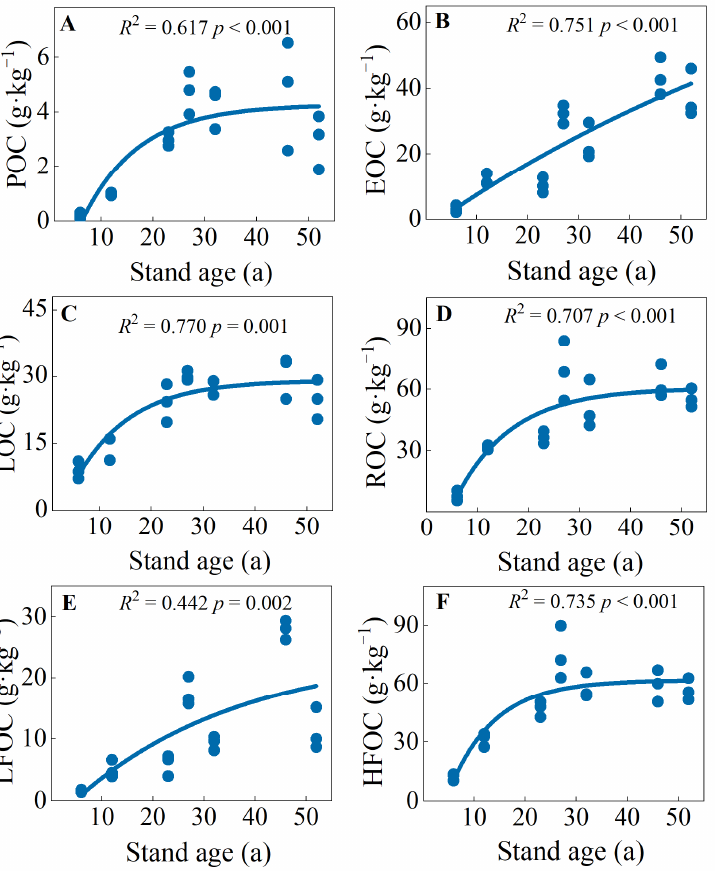
Figure 2. ( A ) soil particulate organic carbon (POC), ( B ) easily oxidizable carbon (EOC), ( C ) labile organic carbon (LOC), ( D ) recalcitrant organic carbon (ROC), ( E ) light fraction organic carbon (LFOC) and ( F ) heavy fraction organic carbon (HFOC) in C. japonica plantations of different stand ages in the rainy area of western China. The proportions of the POC, EOC, LOC, ROC, LFOC, and HFOC to SOC were 1.2%–5.4%, 16.8%–46.7%, 30.8%–53.9%, 46.1%–69.1%, 9.1%–30.1%, and 63.3%–77.6%, respec- tively (Table 2). The proportion of carbon fractions to SOC varied among stand ages (Table 2). Specifically, the POC/SOC of young, middle-aged, and mature forests were signifi- cantly lower than those of other stand ages (Table 2). The rank of an average value of the EOC/SOC was over-mature forests > mature forests > near-mature, middle-aged, and young forests. The LOC/SOC of young forests was higher than that of other stand ages, but a contrasting result was observed in ROC/SOC. The highest and lowest proportion of the LFOC/SOC was observed in the early over-mature forests (46 a) and young forests,